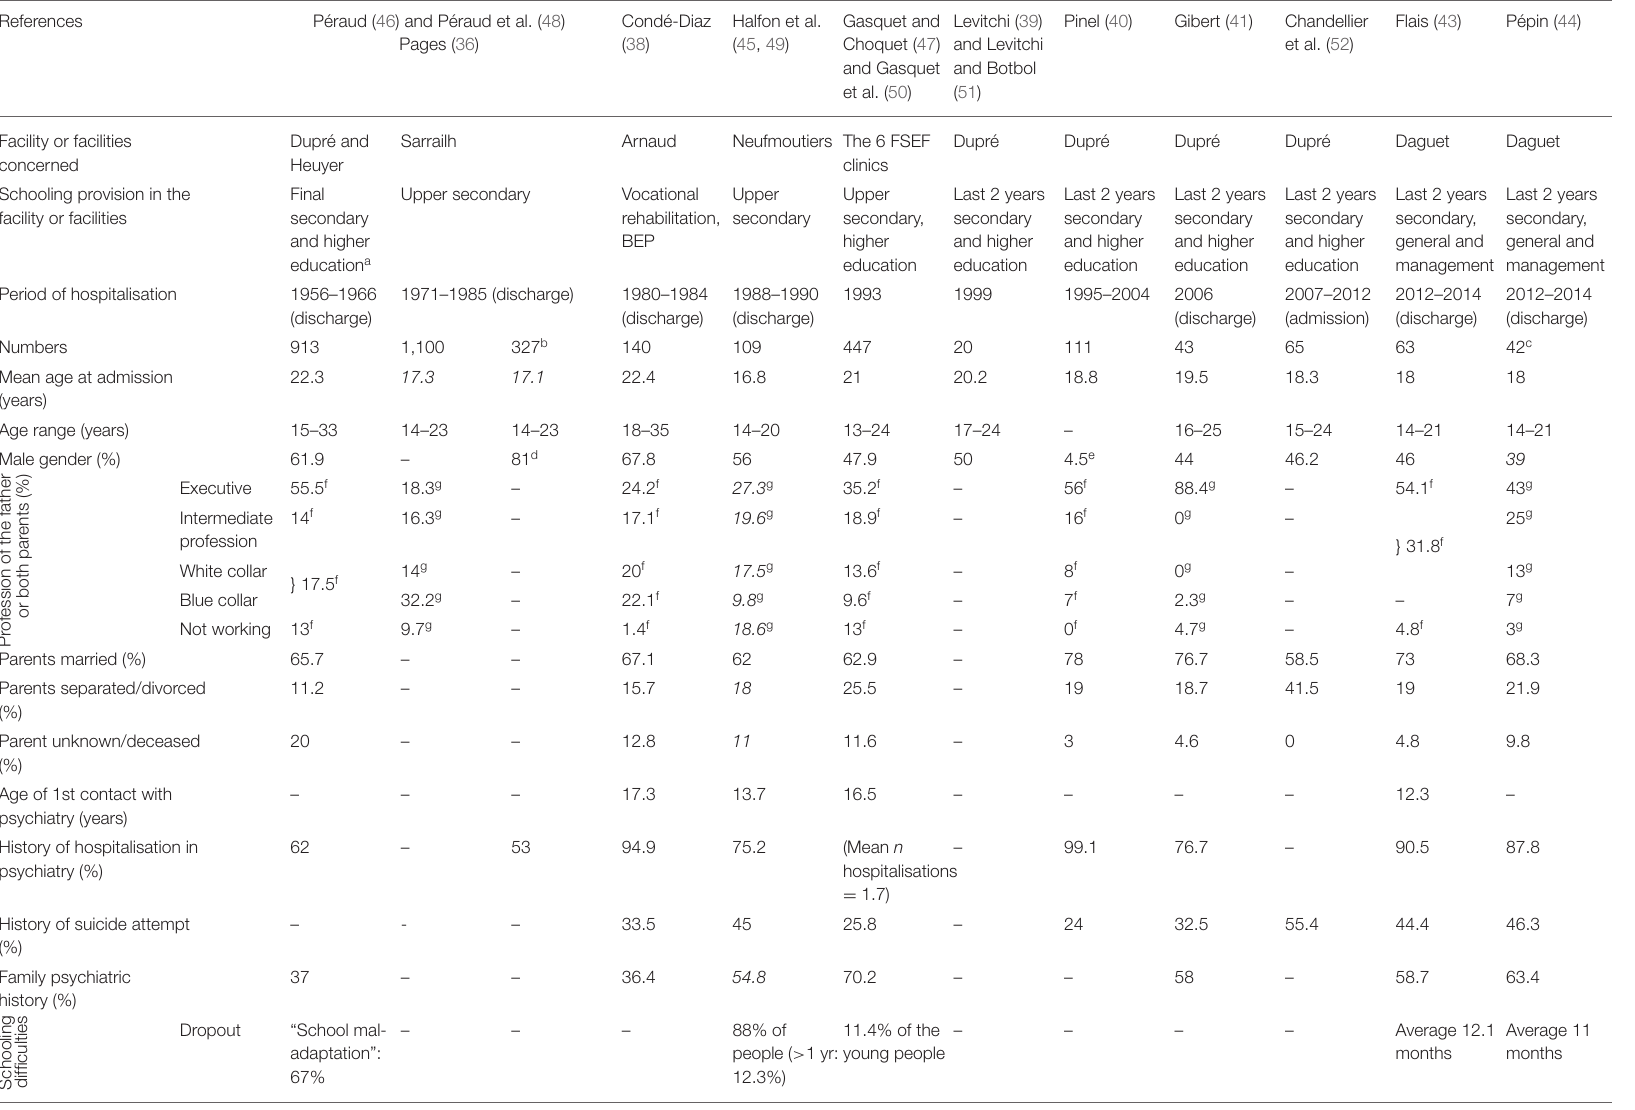
TABLE 1 | Characteristics of the population admitted to soins-études in